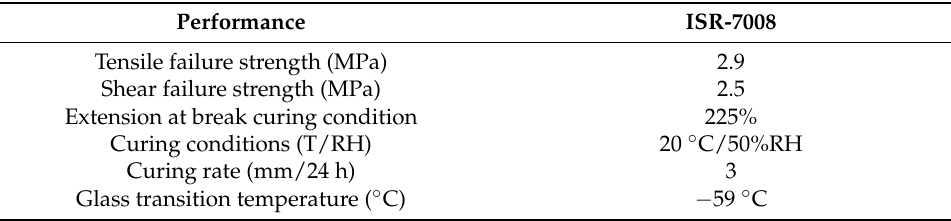
Table 2. Technical performance parameters of ISR-7008